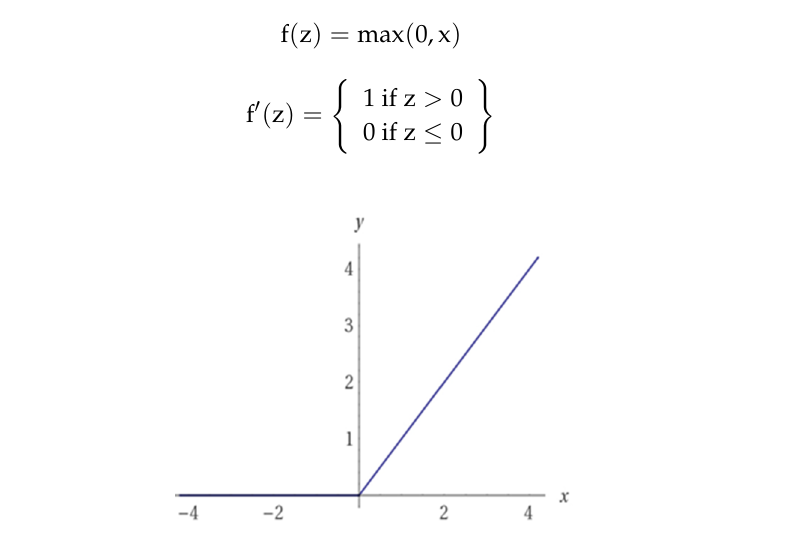
Figure 2. Relu activation function.